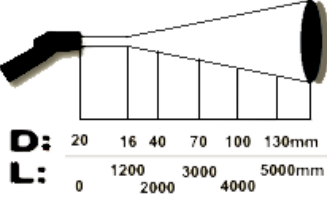
Figure 9. The size of the measured area for the used pyrometer using standard optics: D – diameter of measured area, L – distance from the object.